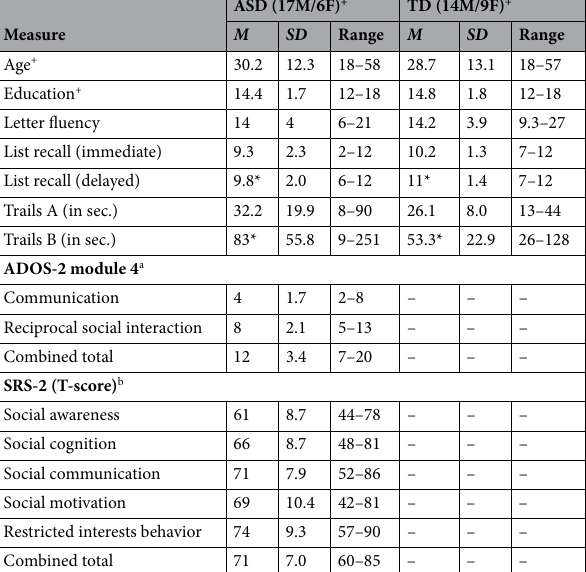
Table 1. Participant demographics. Note. + indicates variables used for matching. * indicates significant group difference ( p < 0.05). a Autism diagnostic observation schedule-2 (ADOS-2), module 4. b Social responsiveness scale-2, adult form self-report